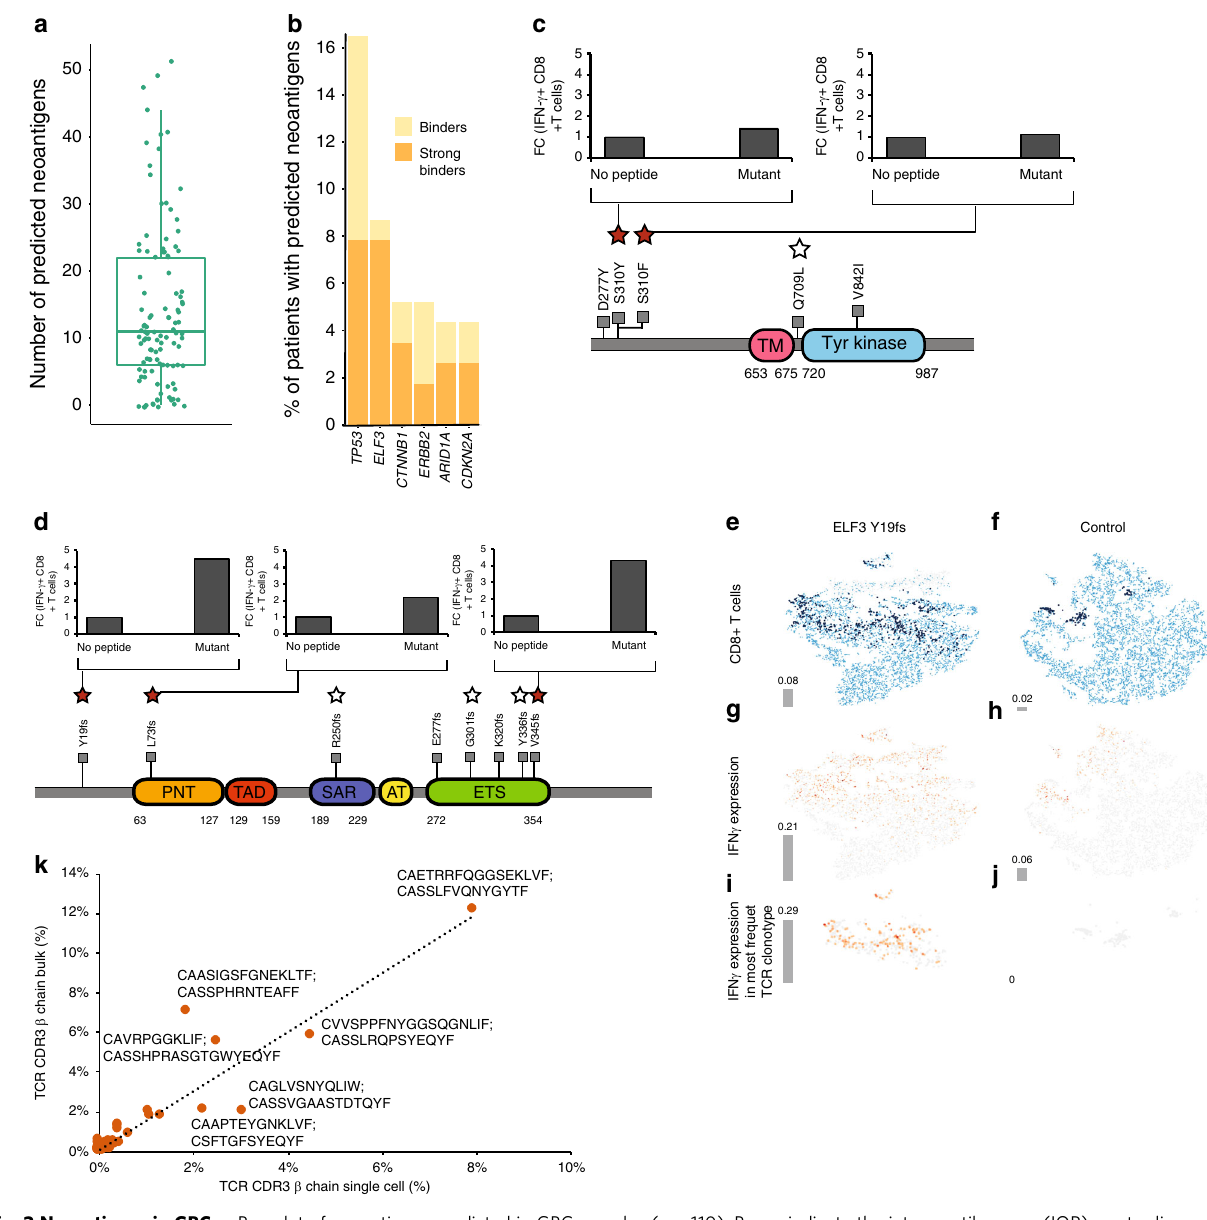
Fig. 3 Neoantigens in GBC. a Box plot of neoantigens predicted in GBC samples ( n = 110). Boxes indicate the interquartile range (IQR); center line, median; whiskers, lowest and highest values within 1.5x IQR from the fi rst and third quartiles, respectively. b Stacked bar plot of genes with the highest number of predicted neoantigens plotted as a percentage of total number of patient tumors with a mutation in that gene ( n = 43). Peptides with predicted MHC I af fi nty of ≤ 500 nm (yellow) and <500 nm (strong binder; orange) are shown in. Schematic of ERBB2 ( c ) or ELF3 ( d ) neoantigen generating mutations and CD8 + T-cell activation measured by INF- γ expression level for the indicated mutant peptides. Stars above the mutation represent peptides tested and solid stars represent CD8 + T-cell activating peptides. t-SNE plots based of single-cell RNA/TCR-seq data for CD8 + T-cells (light blue) co-cultured with dendritic cells expressing either the ELF3 Y19fs minigene ( e ) or control vector ( f ). Dark blue represents the most abundant αβ CD8 TCR clone and gray is non-CD8 + T-cells. IFN- γ expression in the total cell population primarily enriched in CD8 + T-cells in the ELF3 Y19fs minigene ( g ) or control vector ( h ) sample. i, j IFN- γ expression observed in the expanded CD8 + T-cells identi fi ed by TCR sequence analysis. k A scatter plot of correlation between the most frequently represented TCR clones identi fi ed by the TCR β chain sequence in the single-cell and PMBC CD8 + T-cell activation assay (see Methods). The TCR α and β chain CDR3 sequence of the top six most clonally expanded T-cell clones are